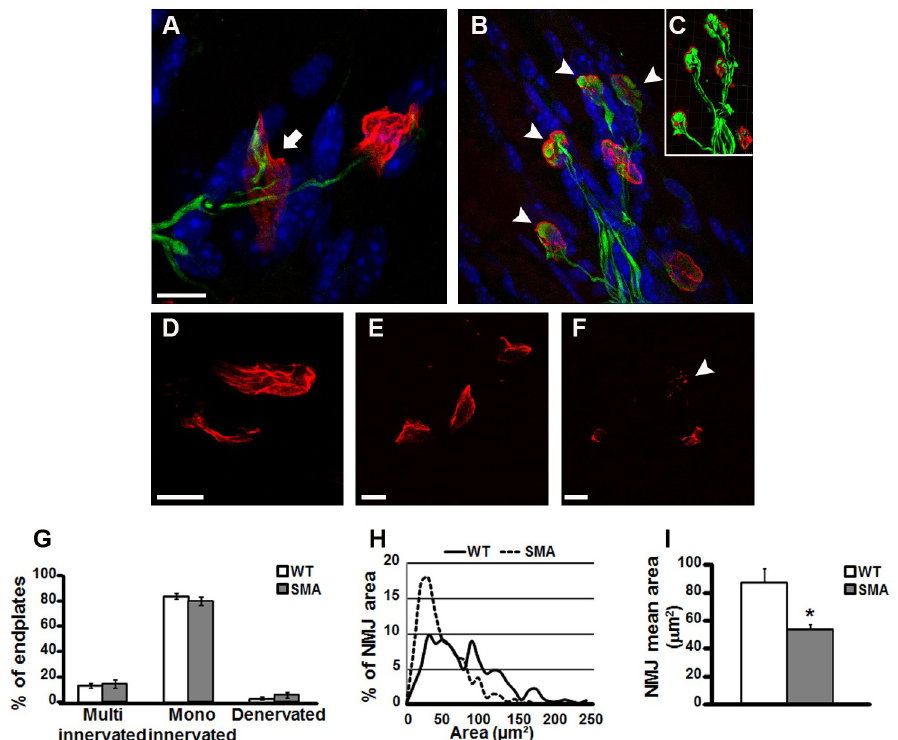
Fig 2. Architecture of the NMJ of the quadriceps in WT and SMA mice at P10. Panels A-B, Immunoreactions for α -bungarotoxin (red) and neurofilament (green) proteins in NMJs of quadriceps of WT (panel A) and SMA (panel B) mice. Inset C, isosurface module of Imaris software. Nuclei were labeled in blue with DAPI. The arrow in A points a WT NMJ correctly innervated, whereas arrowheads in B show the abnormal accumulations of neurofilament in SMA. Scale bar = 10 μ m. Panels D-F, morphology of NMJs at higher magnification: WT mice display endplates with a more mature morphology (panel D), compared to SMA ones (panel E). Additionally rare SMA NMJs appear fragmented, as indicated by arrowhead (panel F). Scale bar = 10 μ m. Panel G, quantification of multi-innervated, mono-innervated and denervated endplates in quadriceps of WT and SMA mice. Panel H, distribution of NMJ area in WT (continuous line) and SMA (dashed line) endplates expressed as percentage of total number of plaques. Panel I, mean value of NMJ area in WT and SMA quadriceps. * p < 0.05 by t-test